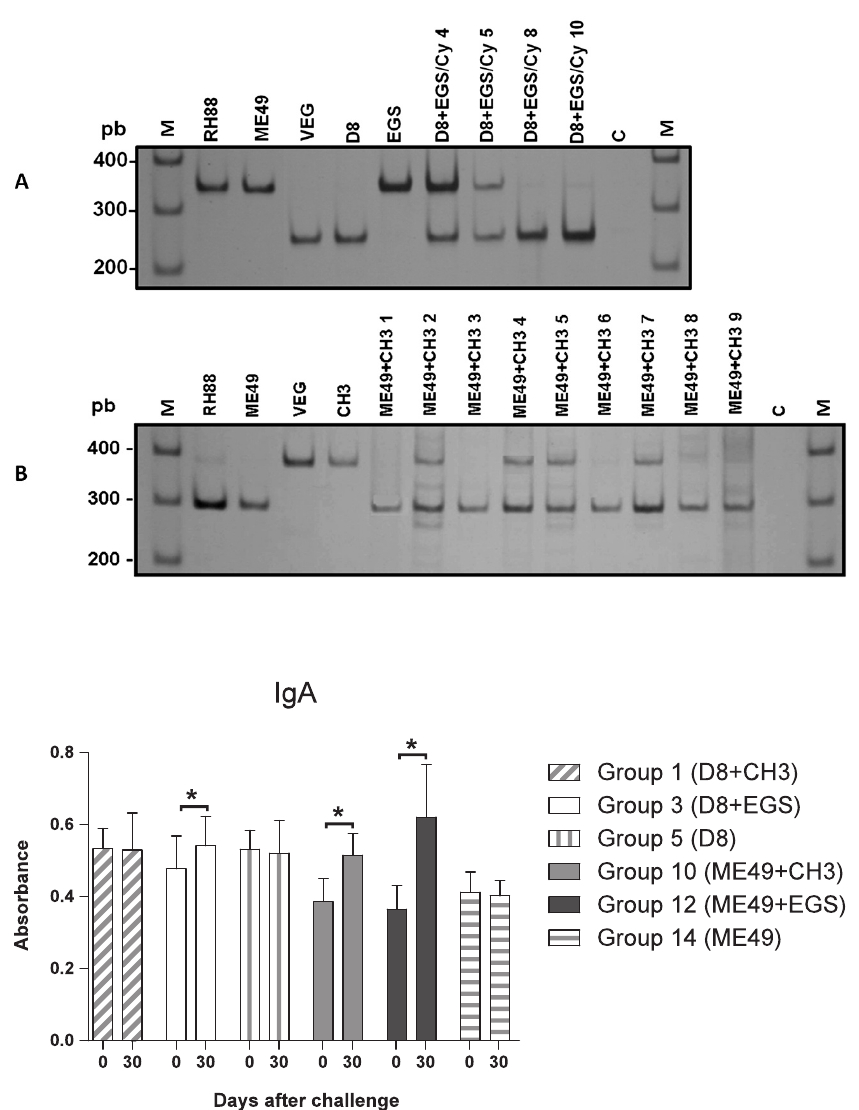
Fig. 1. – Polymerase chain reaction- restriction fragment length polymor- phism (PCR-RFLP) of Toxoplasma gondii in 5 % polyacrylamide gel silver stained to verify reinfection.